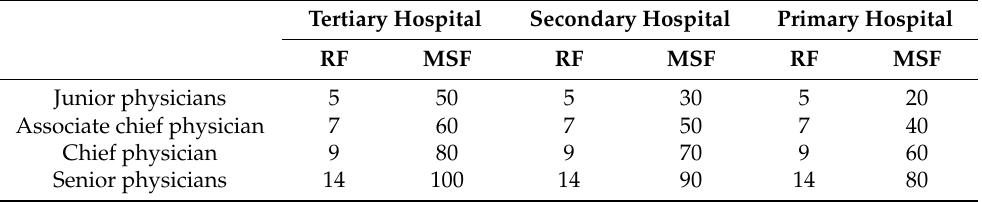
Table 1. Registration fee (RF) pre-reform and medical service fee (MSF) post-reform. Unit: CNY.